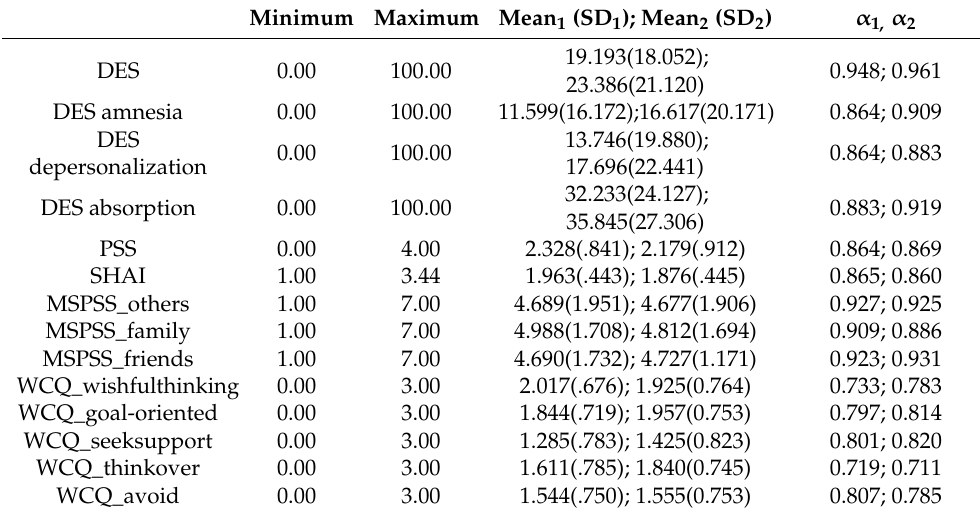
Table 2. Descriptive statistics for variables of international